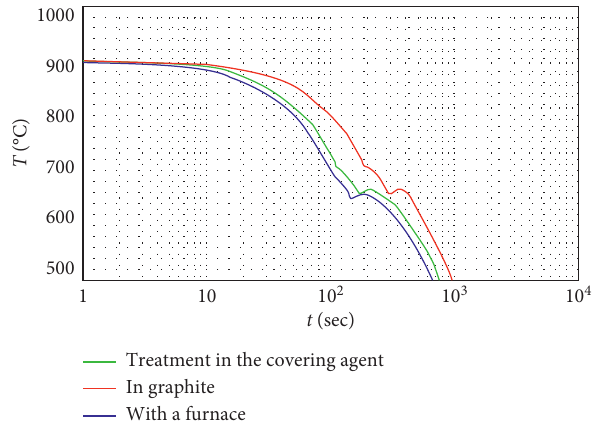
Figure 17: Temperature change of deposited steel S 45 samples with a diameter of 20 mm when exposed to a covering agent as compared with standard cooling